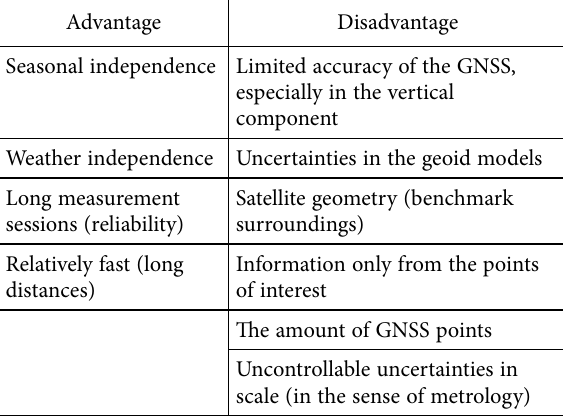
Table 2. Advantages and disadvantages related to GNSS